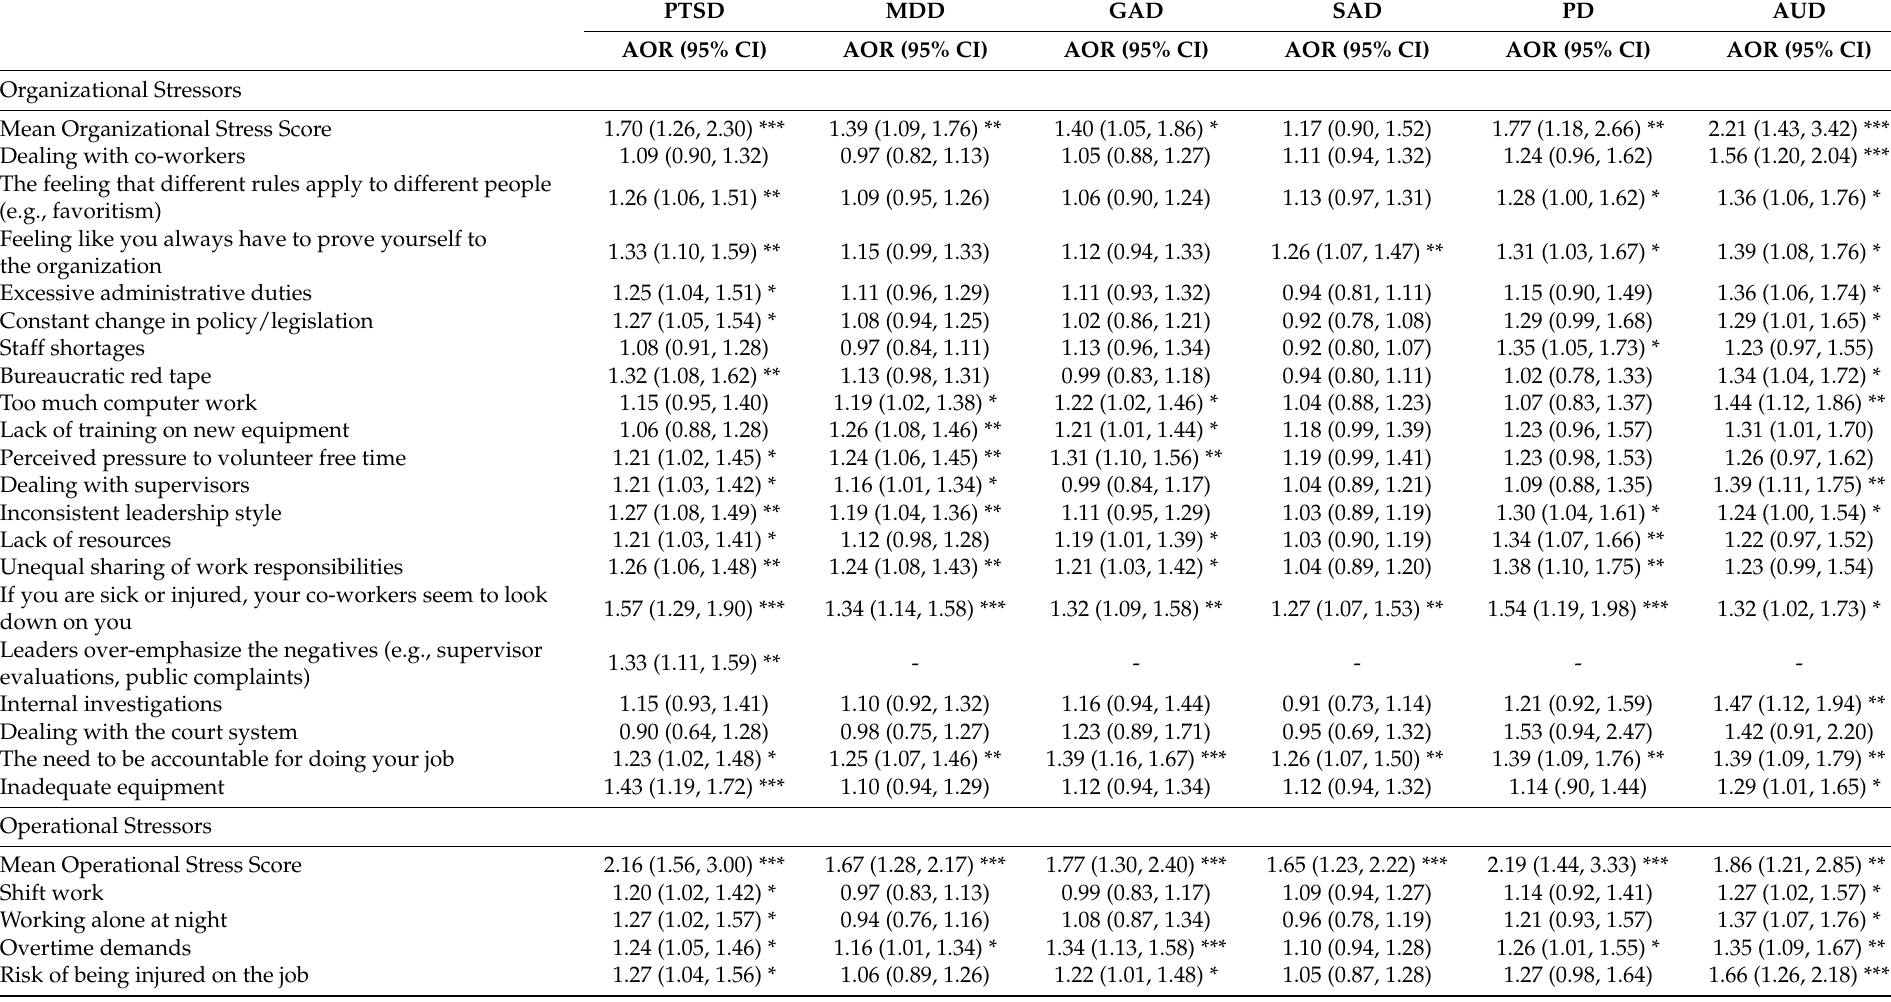
Table 4. Association Between Occupational Stressors and Positive Screens for Mental Health